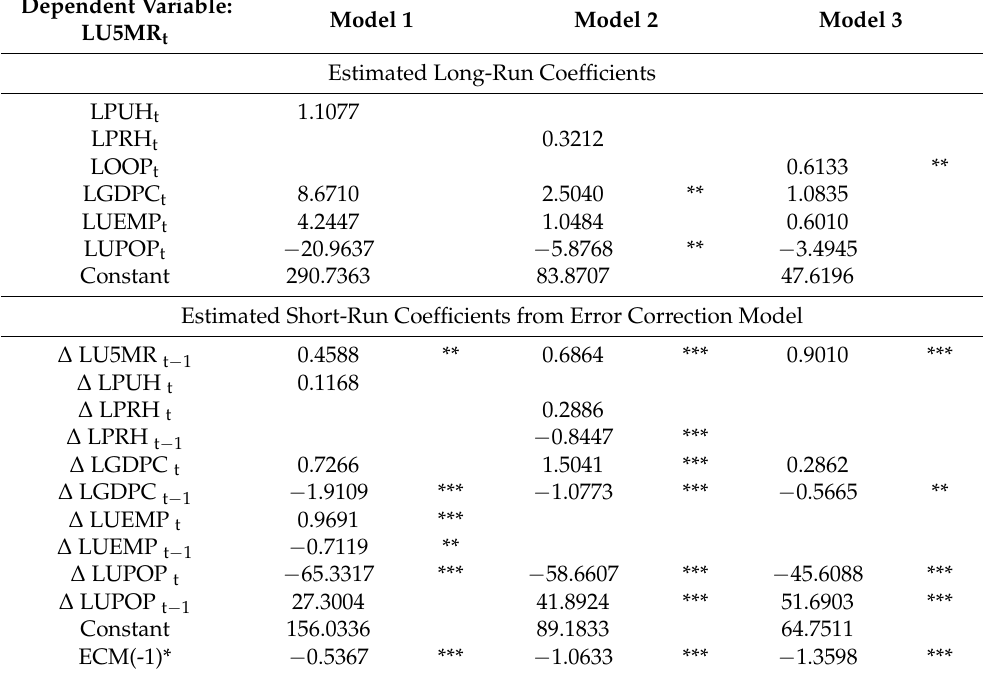
Table 4. Long-Run